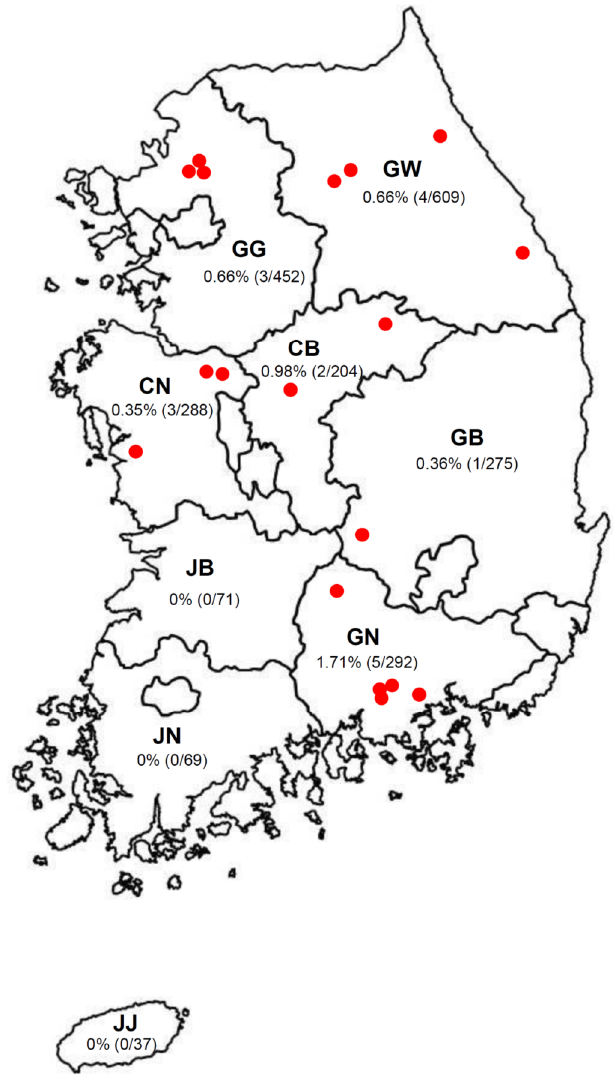
Figure 1. Locations in which APPV-positive wild boars were captured. Locations in which wild boars were captured are marked by a red dot. GW: Gangwon; GG: Gyeonggi; GN: Gyeongnam; GB, Gyeongbuk; JN: Jennam; JB: Jenbuk; CN: Chungnam; CB: Chungbuk; JJ: Jeju.